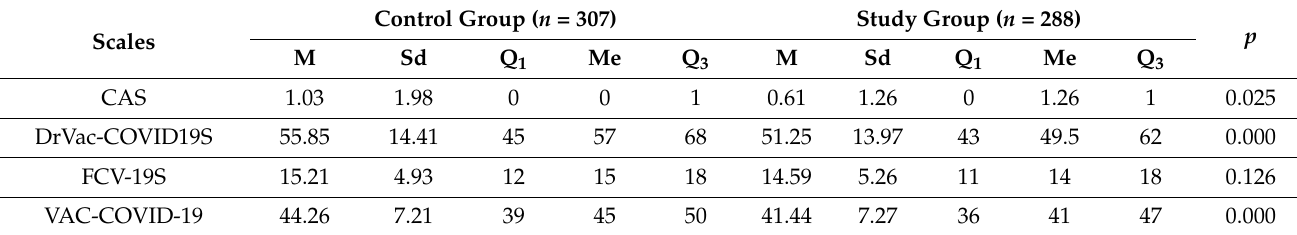
Table 4. Descriptive statistics of standardised